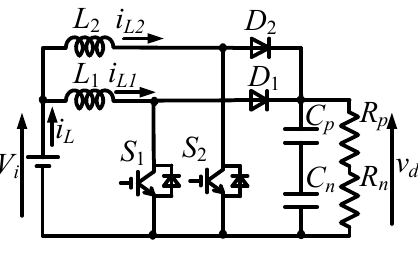
Figure 1. Parallel circuit.